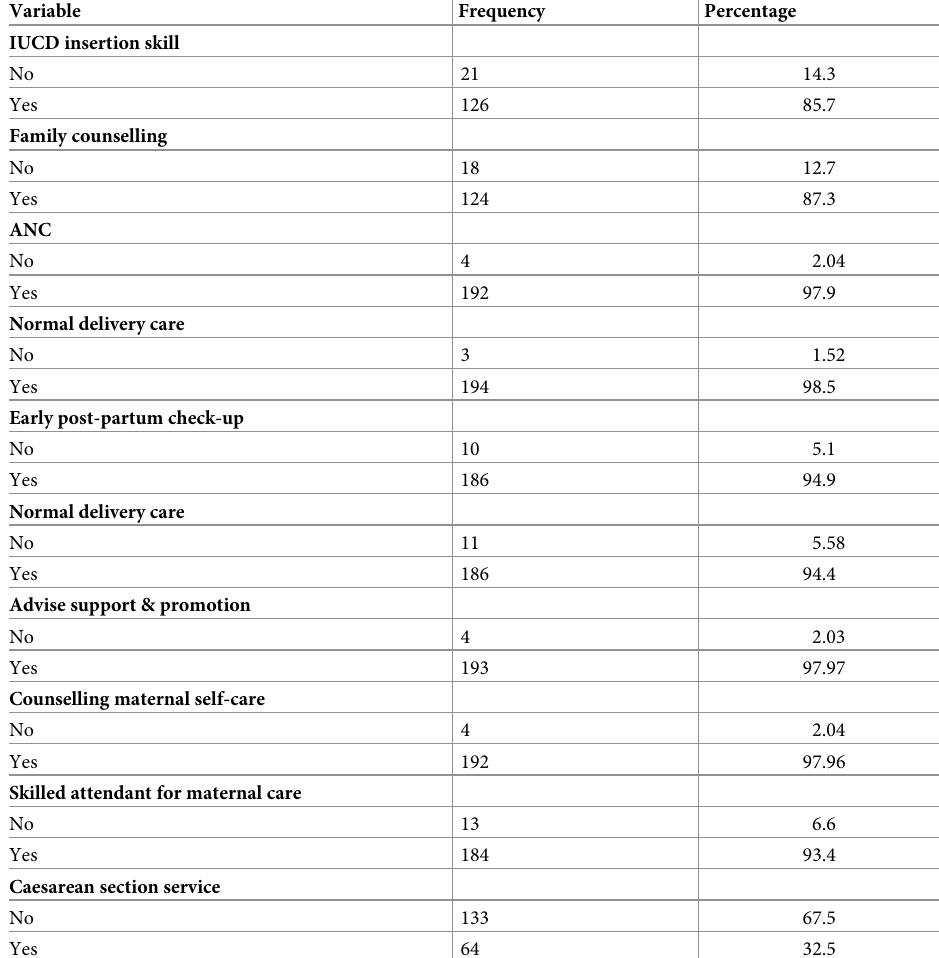
Table 2. Provider knowledge and practice in family planning service among Amhara regional state health facility, Ethiopia, (2016).